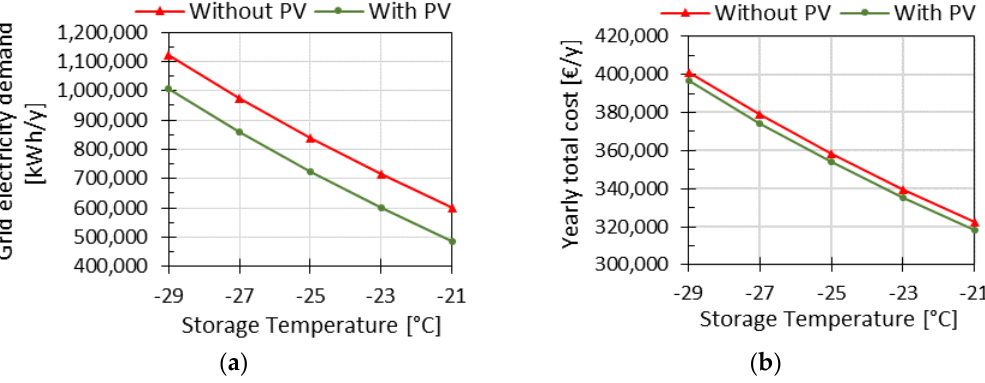
Figure 10. Sensitivity analysis on storage temperature: ( a ) electricity withdrawal from the grid and ( b ) yearly total cost.